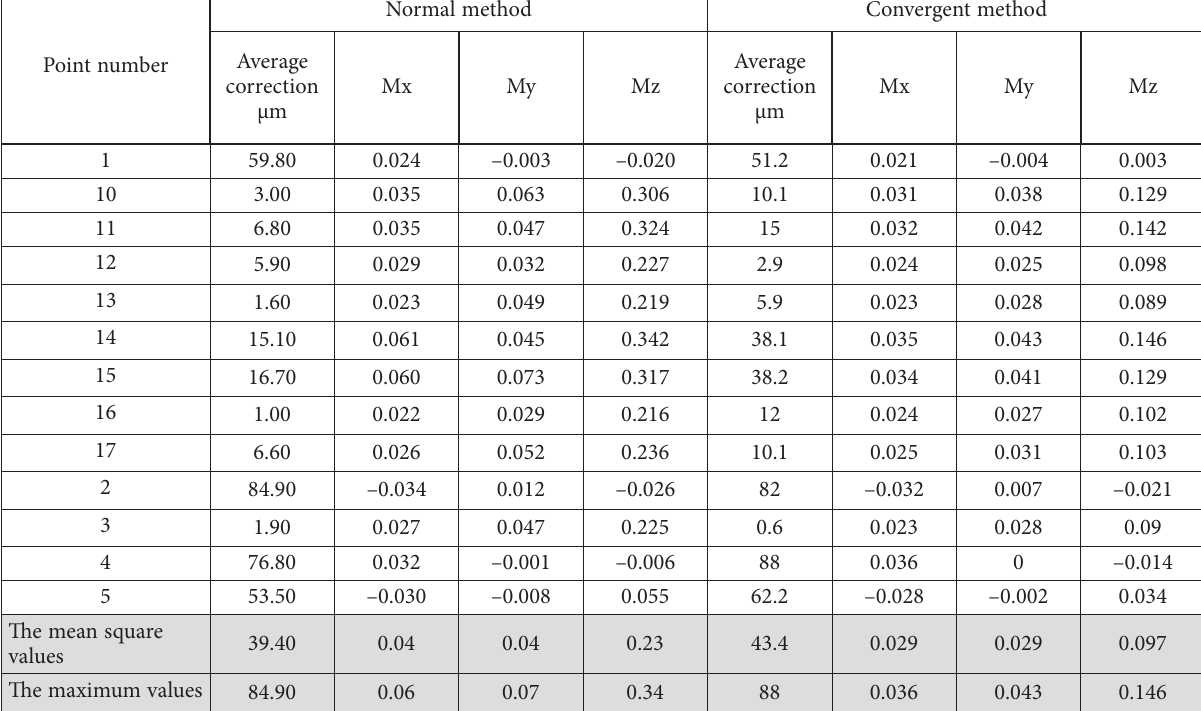
Table 6. Comparison of root mean square errors at reference and connecting